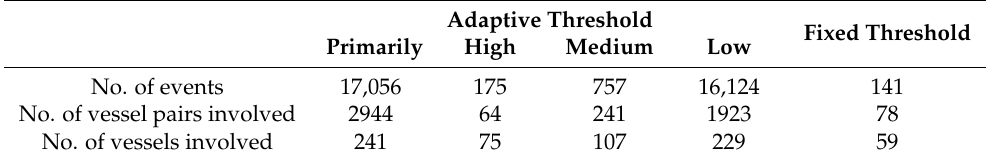
Table 6. Result comparison in Brest, France test dataset.